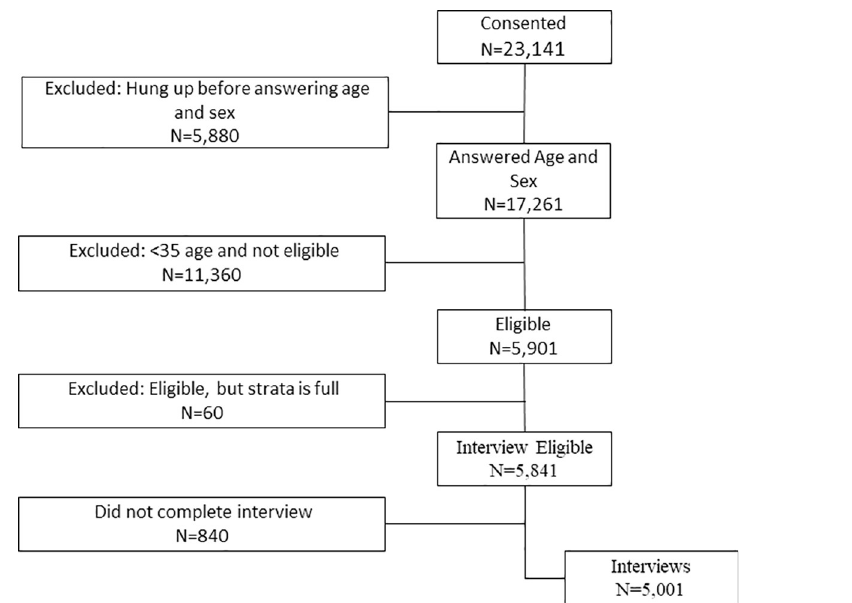
Fig 4. Sri Lanka COVID-19 mobile phone survey data flow.